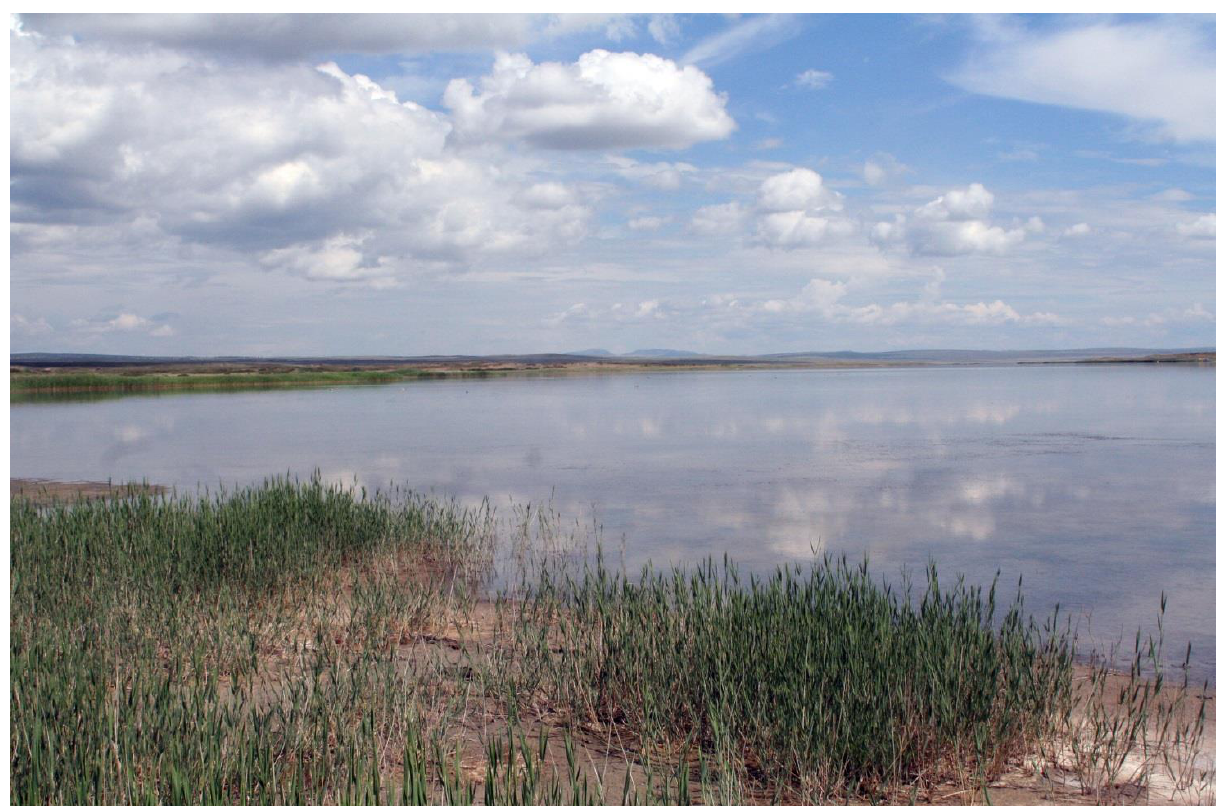
Fig. 4. Brackish Lake Khadyn. Tanda Kozhuun, 2 July